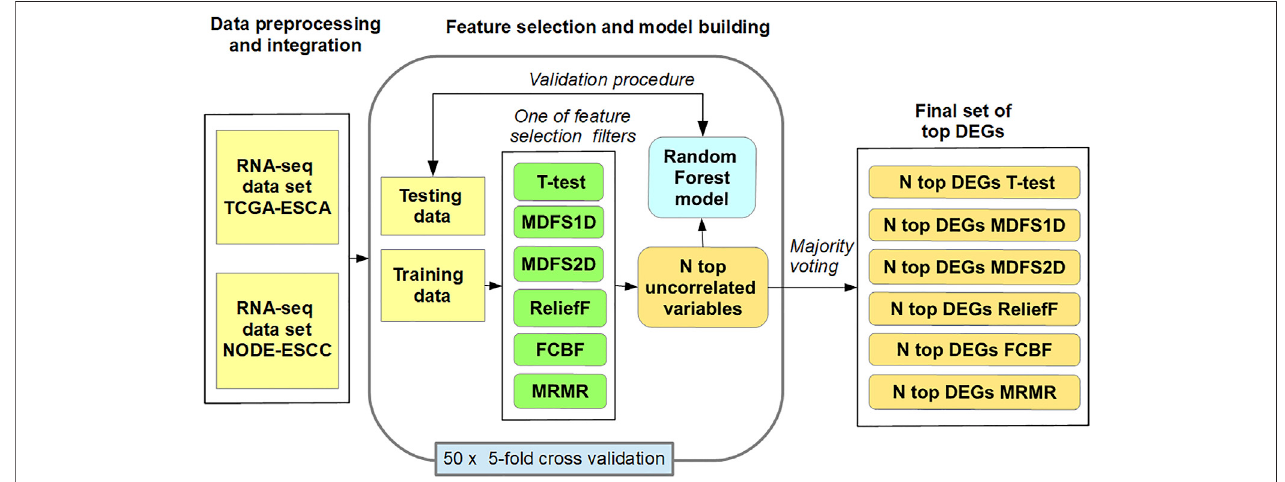
FIGURE 1 | Procedures involved in selecting the most informative